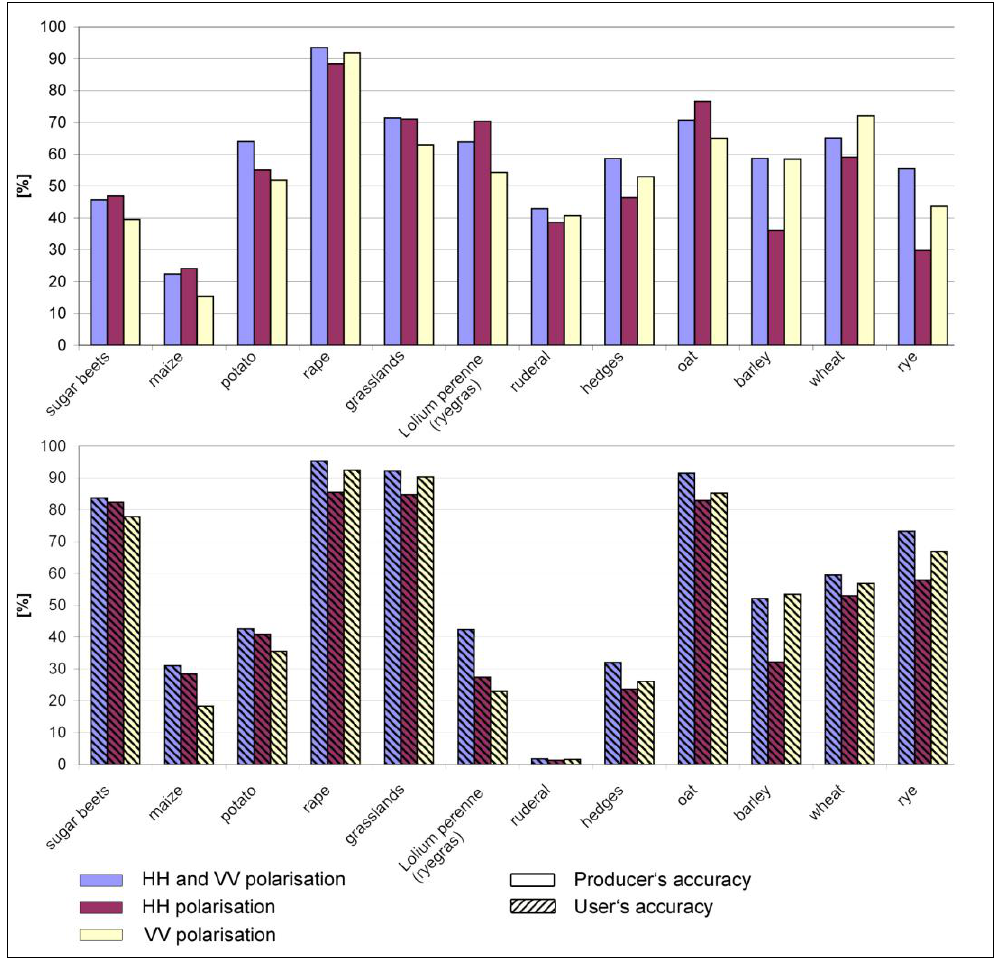
Figure 7. Producer‘s and user‘s accuracies for single classes in the Fuhrberg